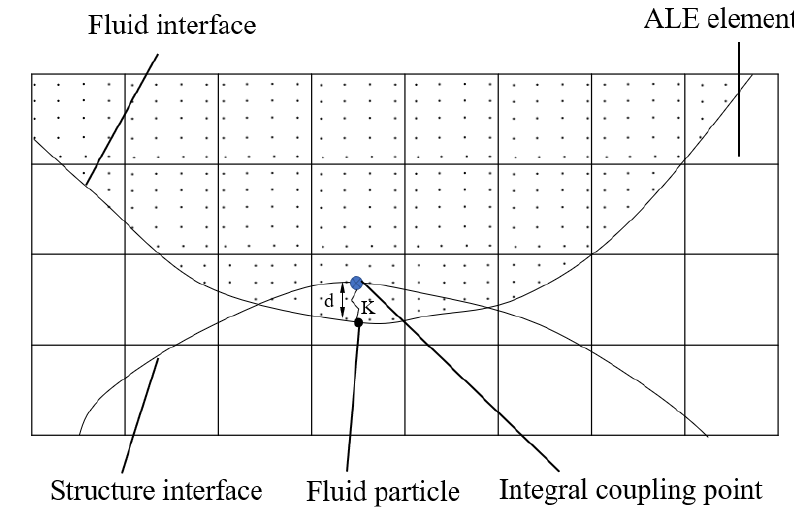
Figure 4. Lagrange-Eluerian coupling diagram.